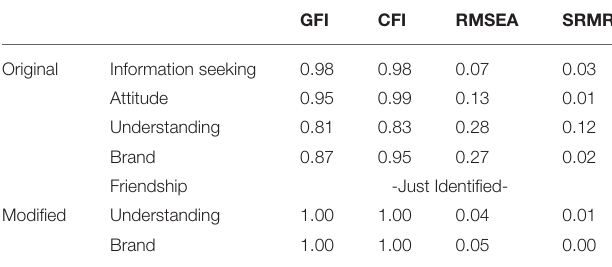
TABLE 1 | Fit statistics.